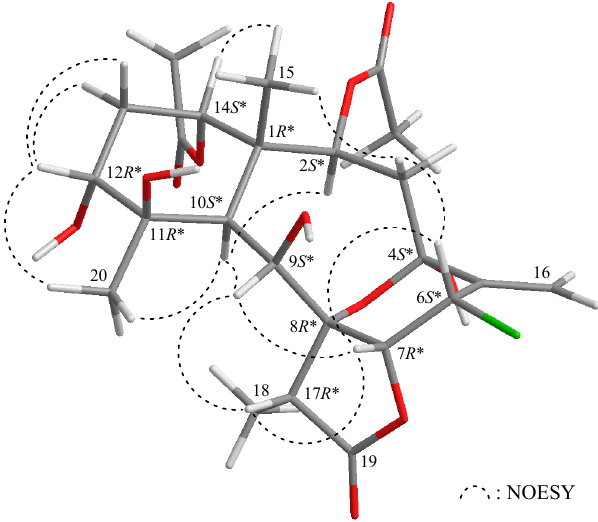
Figure 2. Selected protons with key nuclear Overhauser effect spectroscopy (NOESY) correlations of 1 . Briarenolide ZII ( 2 ) was isolated as a white powder and had a molecular formula of C 28 H 38 O 10